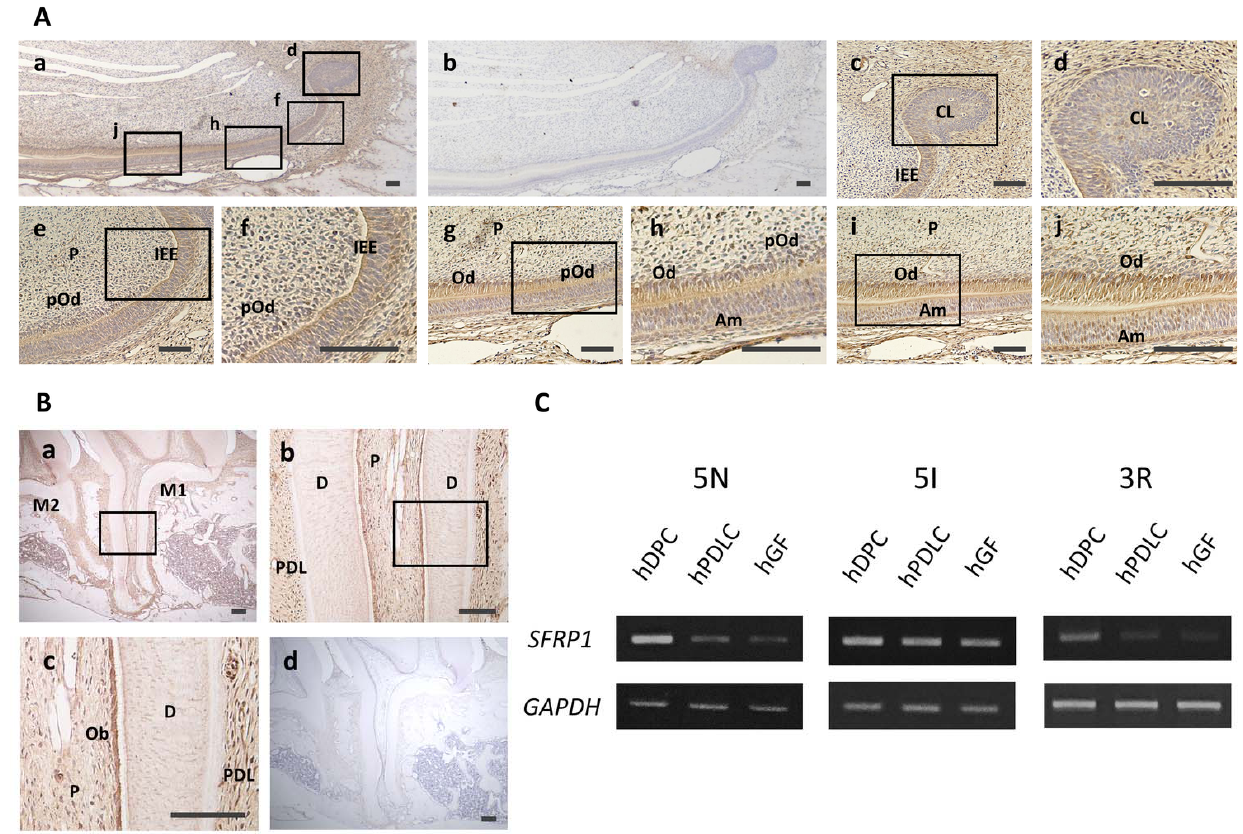
Figure 1. Localization of Sfrp1 in rat dental tissues and expression of SFRP1 mRNA in human dental cells. ( A ) Immunohis- tochemical staining of mandibular incisors of 8-week-old male Wistar rats with an anti-Sfrp1 antibody. Lower magnification images of anti-Sfrp1 ( a ) and rabbit control IgG ( b ) staining of mandibular incisor. ( c , e , g , i ) Higher magnification images in ( a ). ( d , f , h , j ) Higher magnification images of black boxes in (a, c , e , g , i ). No positive staining was detected in the cervical loop ( c , d ). Faint positive staining was confirmed in the inner enamel epithelium ( e , f ), dental pulp ( e , f ), preodontoblast layer ( e – h ), and ameloblast layer ( g , h ). Intense positive staining was found in the odontoblast layer ( g – j ). ( B ) Immunohistochemical staining of mandibular first molar of 8-week-old male Wistar rats with an anti-Sfrp1 antibody ( a – c ) or rabbit control IgG ( d ). ( b , c ) Higher magnification images of black boxes in ( a , b ), respectively. Odontoblasts strongly expressed Sfrp1 compared with cells in the dental pulp and periodontal ligament. ( C ) Semi-quantitative RT-PCR analysis of SFRP1 gene expression in hDPCs, hPDLCs, and hGFs. In all three specimens, SFRP1 was strongly expressed in hDPCs compared with one in hPDLCs and hGFs. RT-PCR, reverse transcription polymerase chain reaction; hDPC, human dental pulp cells; hPDLC, human periodontal ligament cells; hGF, human gingival fibroblasts. Experiments were performed in duplicate. Representative data are shown. Bars = 100 µ m. IgG, immunoglobulin G; CL, cervical loop; IEE, inner enamel epithelium; P, dental pulp; Am, ameloblast; pOd, preodontoblasts; Od, odontoblasts; M1, first molar; M2, second molar; D, dentin; PDL, periodontal ligament.